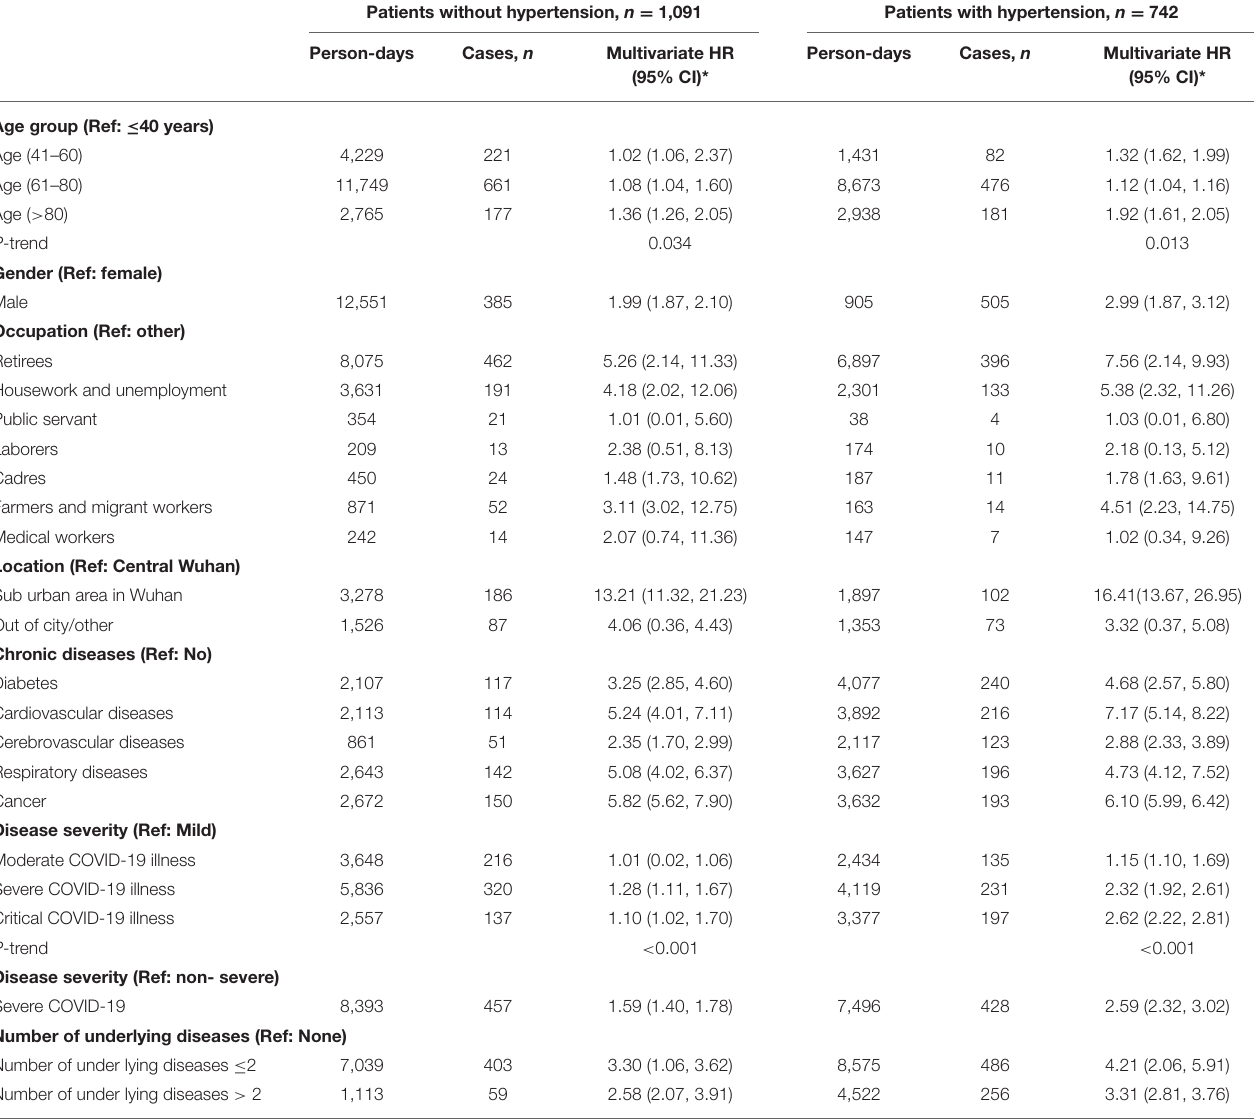
TABLE 4 | Multivariable Cox regression analysis for factors associated with the mortality in 1,833 COVID-19 patients stratified by the hypertension status before the propensity score-matching for age and sex. Patients without hypertension, n = 1,091 Patients with hypertension, n = 742 Person-days Cases, n Multivariate HR Person-days Cases, (95% CI)*